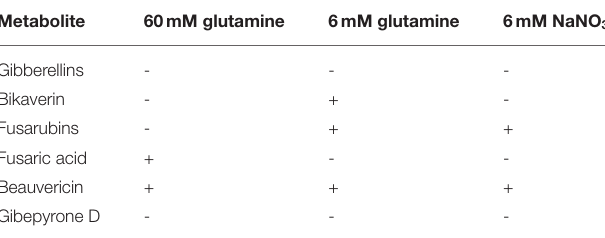
FIGURE 2 | Impact of FmKMT1 deletion on vegetative growth and asexual development. (A) Radial hyphal growth of F. mangiferae wild-type (FmWT), 1 fmkmt1 and 1 fmkmt1 / FmKMT1 Ces was assessed on complete media (FCM, PDA, V8) and minimal media (FMM and ICI supplemented with 6mM NaNO 3 ). For this, strains were grown for 5 days at 30 ◦ C in the dark. Experiments were performed in biological triplicates. Hyphal growth of FmWT on the respective media was arbitrarily set to 100%. Mean values and standard deviations are shown in the diagram. For statistical analysis a student’s t- test was performed. Asterisks above the bars denote significant differences in the vegetative growth of the indicated strains compared to the respective wild type, * p < 0.05; ** p < 0.001. (B) FmWT conidia under L/D and D conditions. FmWT produces under L/D micro- and macroconidia, while under D conditions only microconidia are formed. Bar in the right corner represents 10 µ m of size. (C) Conidiation assay under L/D and D conditions was performed on vegetable V8 media for FmWT, 1 fmkmt1 , and 1 fmkmt1 / FmKMT1 Ces and assessed after 7 days of incubation. Experiments were performed in triplicates. Conidia production of FmWT was arbitrarily set to 100%. Statistical analysis were performed with a student’s t- test. Asterisks above the bars denote significant differences in the conidia production of the indicated strains compared to the respective wild type, * p < 0.05; ** p < 0.001. TABLE 1 | SM production in F. mangiferae under inducing